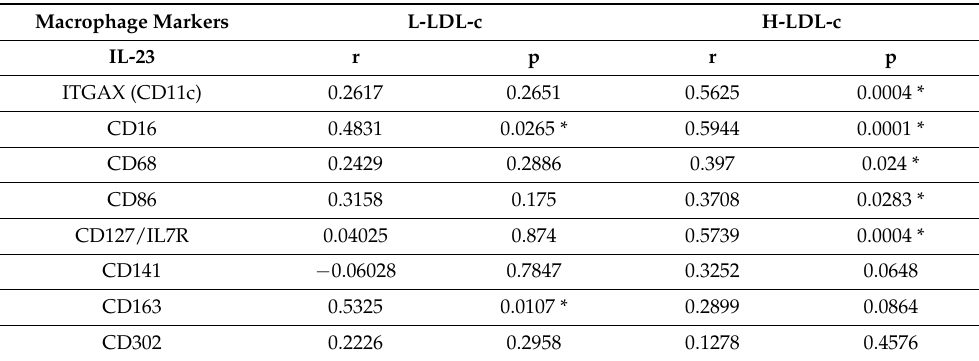
Table 3. Adipose tissue IL-23 mRNA expression correlates with multiple macrophage markers in people with H-LDL-c.